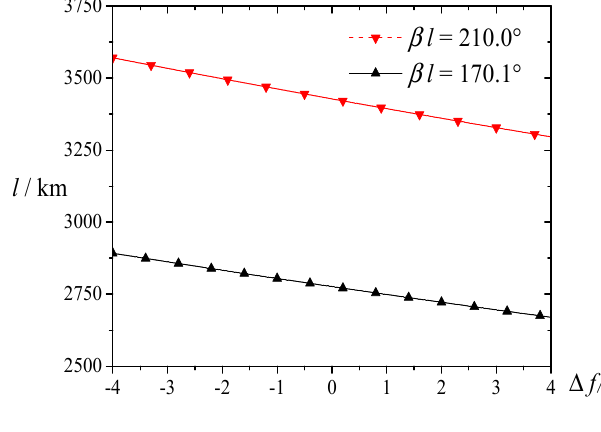
Figure 6. l of different frequency.